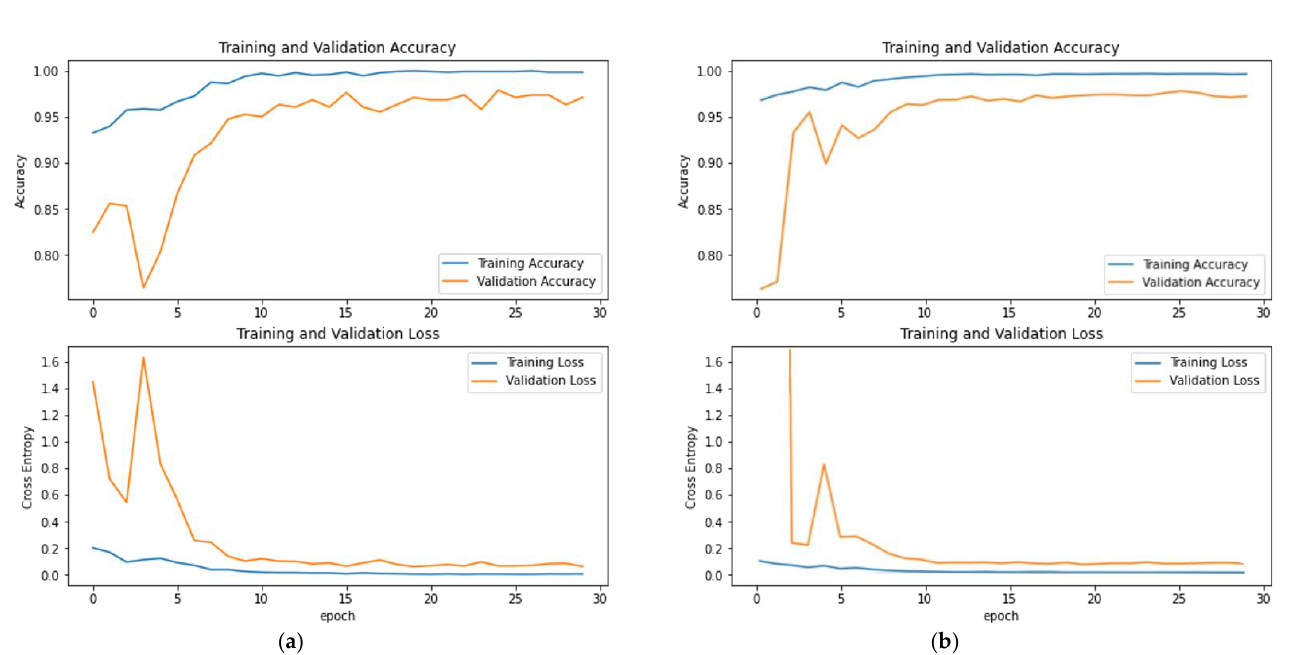
Figure 12. The training and validation curves of ( a ) the DenseNet121 and ( b ) the Inception-ResNetV2.